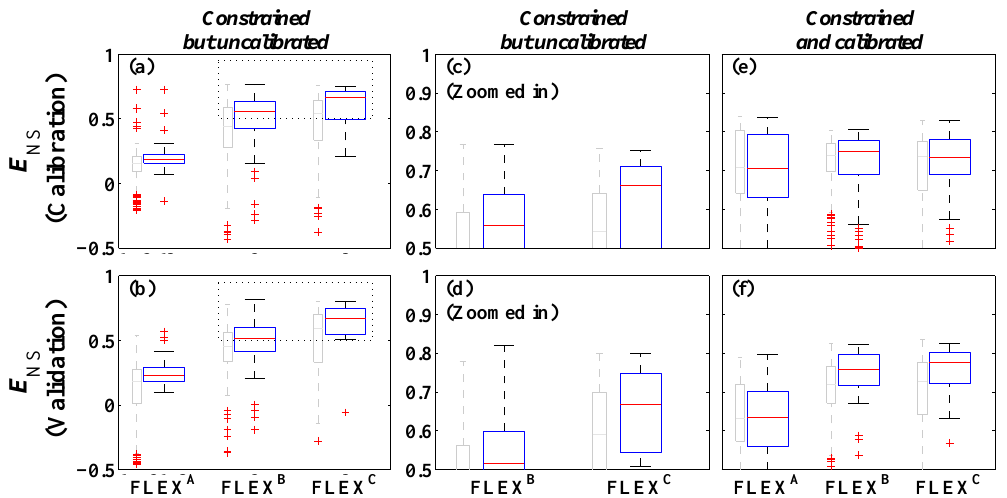
Figure 5. Model performance ( E NS ) based on constrained but uncalibrated (a–d) and constrained and calibrated (e–f) parameter sets for calibration (2002–2005) and validation (2006–2009) periods for the three different model setups FLEX A , FLEX B and FLEX C . Note that (c) and (d) are zoom-ins of (a) and (b) and the gray box-plots represent the unconstrained benchmark models. The box plots indicate the median value in red and 25 and 75% quartile. Whiskers represent the 1.5 times the interquartile range (IQR) and the red crosses show